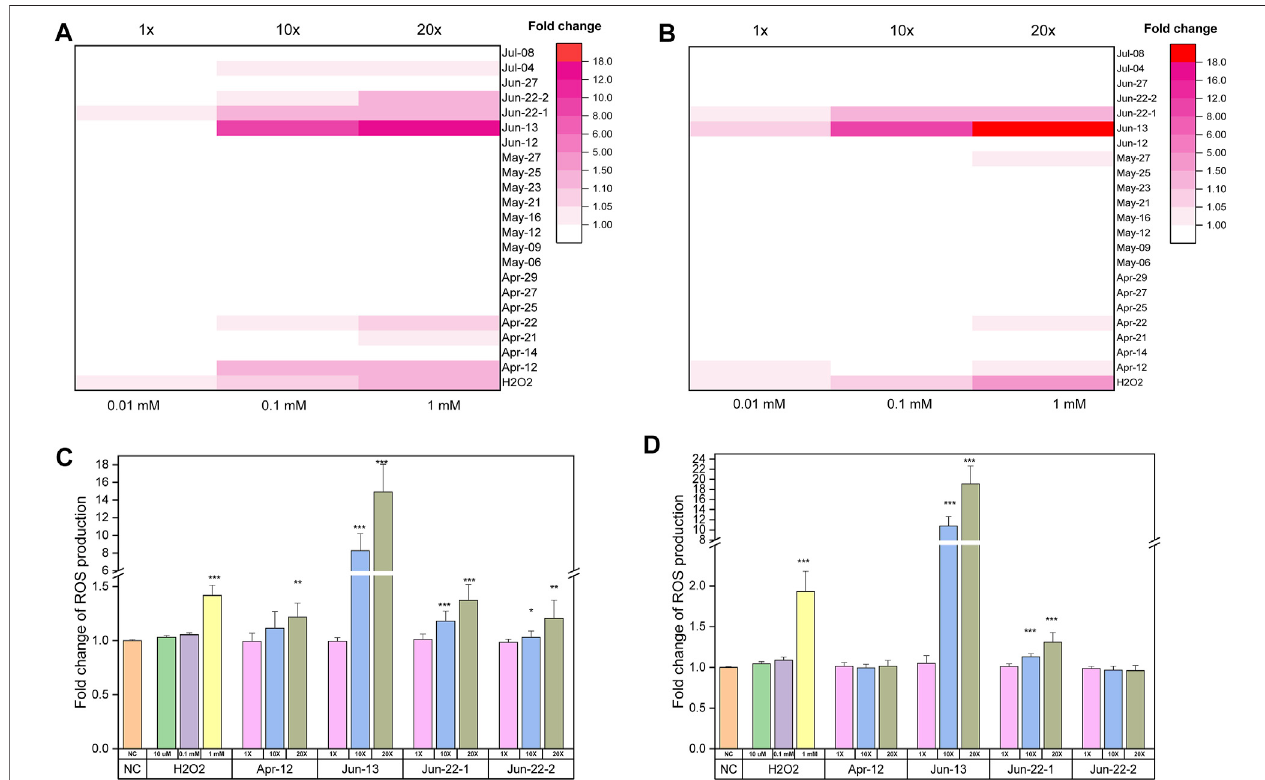
FIGURE 5 | Flow cytometry detection results of intracellular ROS generation when exposing 10 7 cfu/ml of A. baylyi ADP1 to hospital samples. (A) and (C) Fold change of ROS production of A. baylyi ADP1 cells after 30 min treatment by hospital samples at ×1, ×10 and ×20 concentration. (B) and (D) Fold change of ROS production of A. baylyi ADP1 cells after 1 h treatment by hospital samples at ×1, ×10 and ×20 concentration, * p < 0.05, ** p < 0.01,*** p < 0.001.